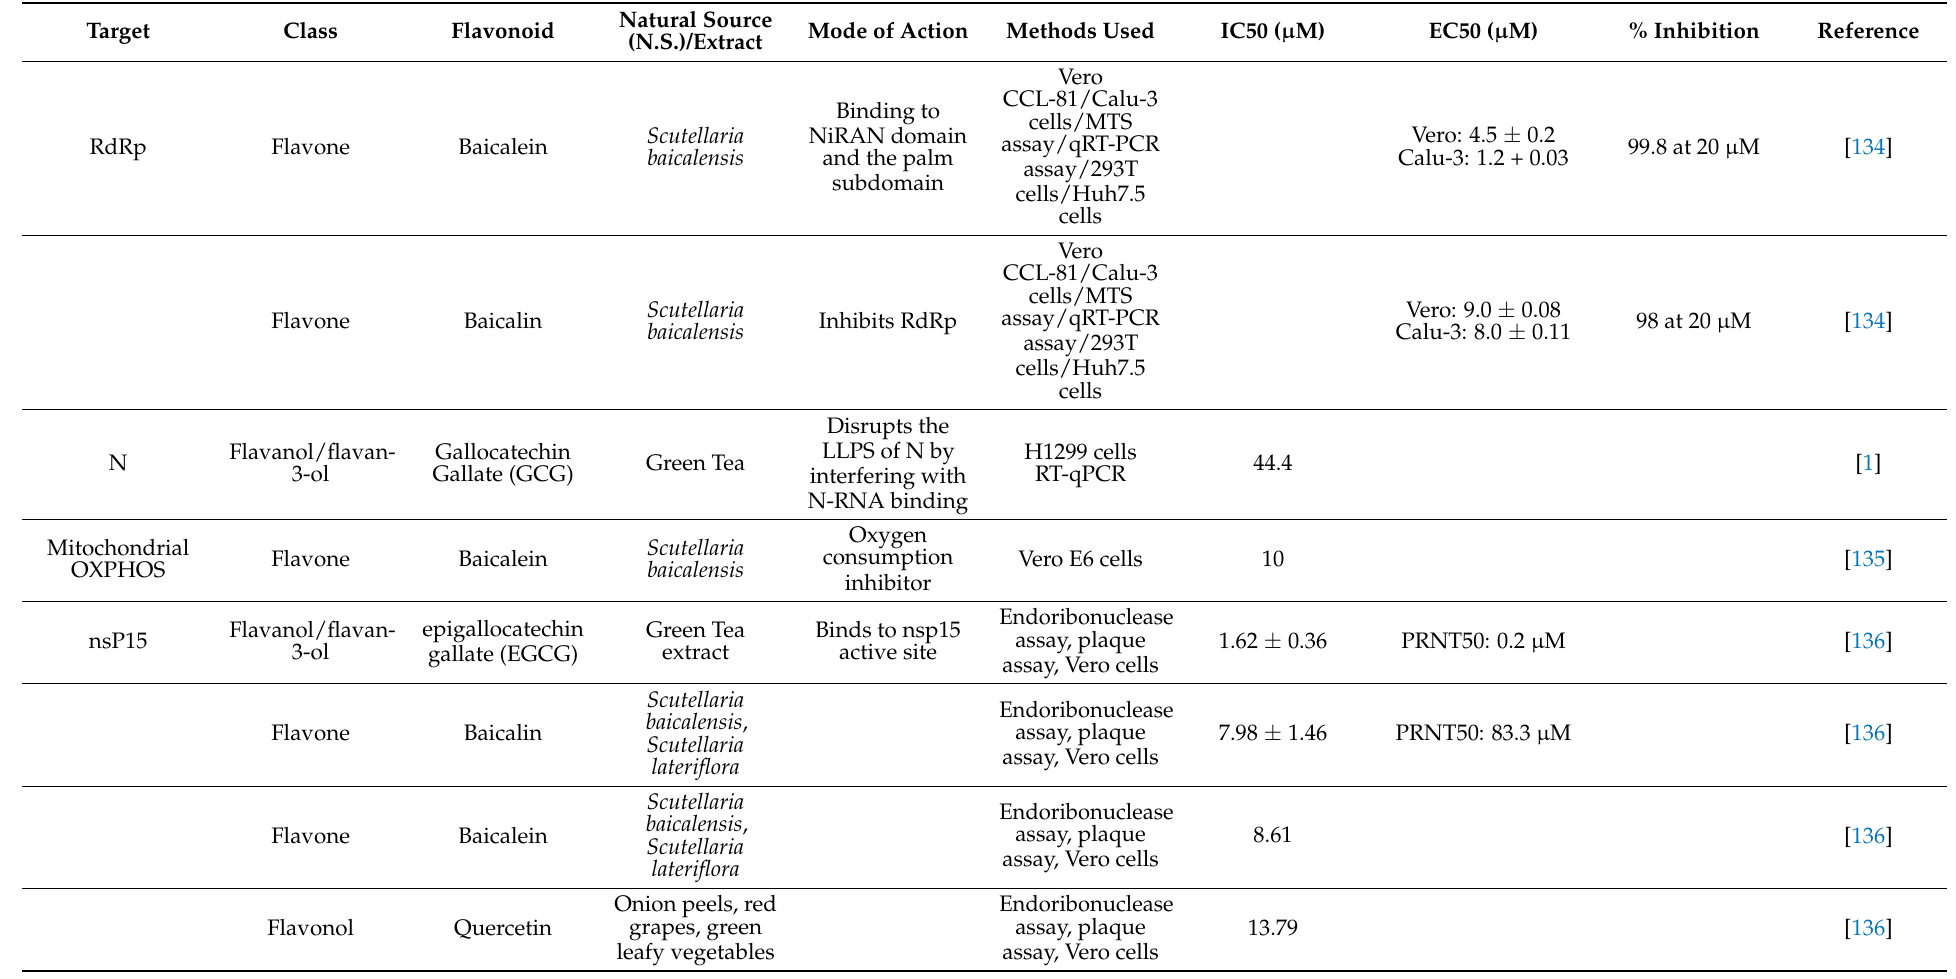
Table 4. Flavonoids with antiviral activities reported against other SARS-CoV-2 targets using in vitro methodologies segregated according to